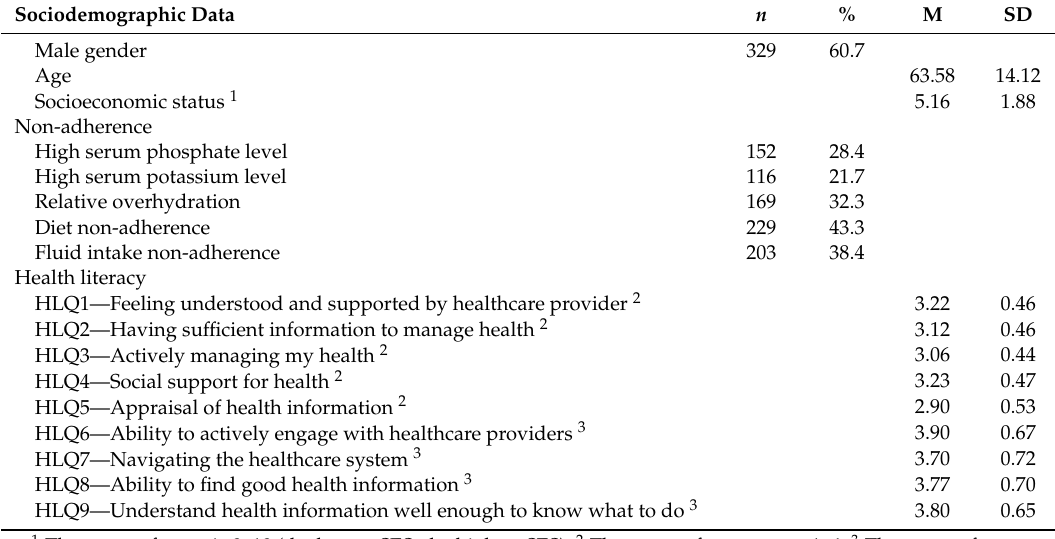
Table 1. Characteristics of the sample: gender, age, and socioeconomic status (SES); measures of non-adherence and health literacy (HL); frequencies or means ( n = 542 patients from 20 dialysis clinics in Slovakia interviewed in